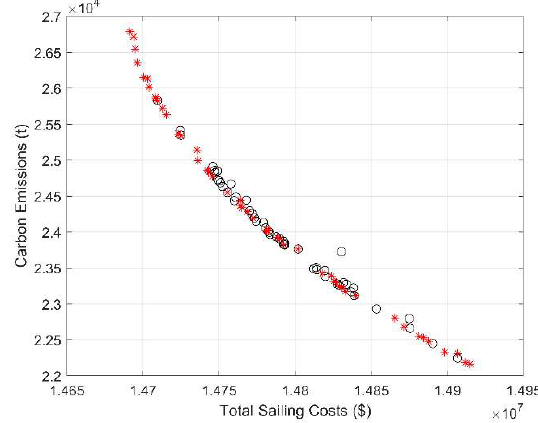
Figure 5. Pareto front for ship cost and emissions. Table 4. 50 objective function values corresponding to Pareto solution.